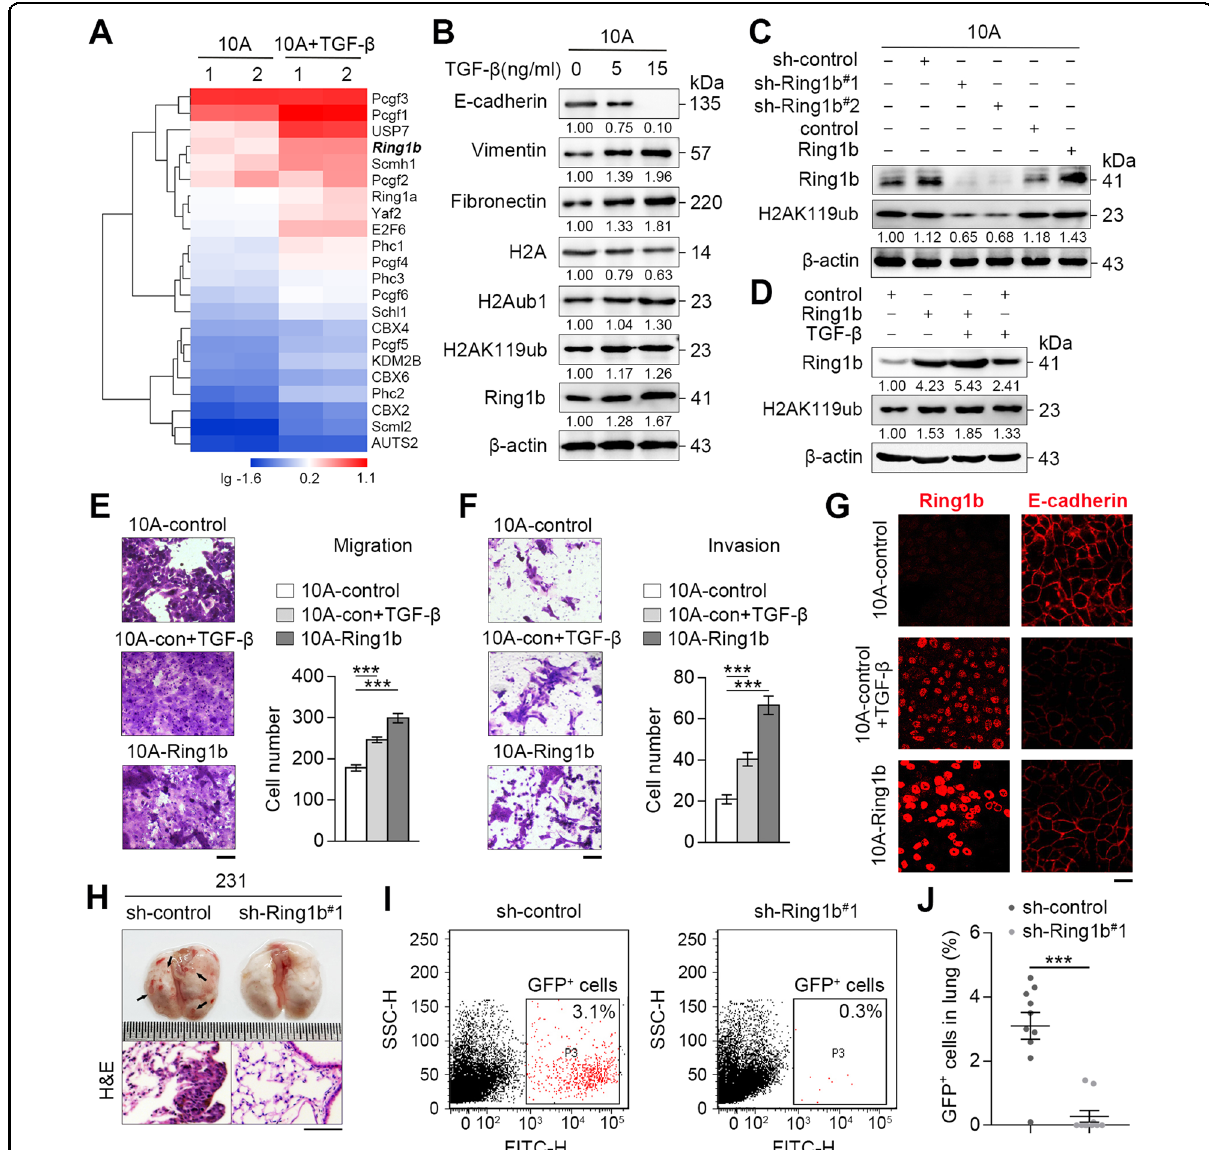
Fig. 1 Ring1b is associated with breast cells metastasis in vitro and in vivo. Ring1b was stably overexpressed or knocked down in cells using lentivirus. A Heatmap of PRC1-genes expression in fl uenced by TGF- β . Total RNAs isolated from 10 A and TGF- β -induced (15 ng/ml, 24 h) 10 A cells were analyzed by qRT-PCR. B Effect of TGF- β on H2Aub1, H2AK119ub, and Ring1b expression. Total protein extractions from 10 A, TGF- β -induced (24 h) 10 A cells were analyzed by western blot. C Effect of Ring1b on H2AK119ub expression. Total protein extractions were analyzed by western blot. D Effect of TGF- β and Ring1b on H2AK119ub expression. Total protein extractions from 10 A and TGF- β -induced (15 ng/ml, 24 h) 10 A cells were analyzed by western blot. E, F Function of Ring1b in cell migration and invasion. 10 A cells were stimulated with TGF- β (15 ng/ml) for 24 h. Statistical analysis of cells migration and invasion by Transwell assays are presented in the bar graphs. Scale bar, 60 μ m. G Immuno fl uorescent staining of Ring1b (red; TRITC) and E-cadherin (red; TRITC) in 10 A cells. 10 A cells were stimulated with TGF- β (15 ng/ml) for 24 h. Scale bar, 25 μ m. H Bright fi eld images and H&E staining of lungs at 6 weeks after mouse tail vein injection. Scale bar, 75 μ m. I, J Flow cytometry analysis of GFP + 231 cells in lungs at 6 weeks after tail vein injection. Statistical analysis shows the percentage of GFP + 231 cells in the lung. Error bars represent the means ± SEM. Unpaired t -test is performed to indicate a statistically signi fi cant difference. *** P <